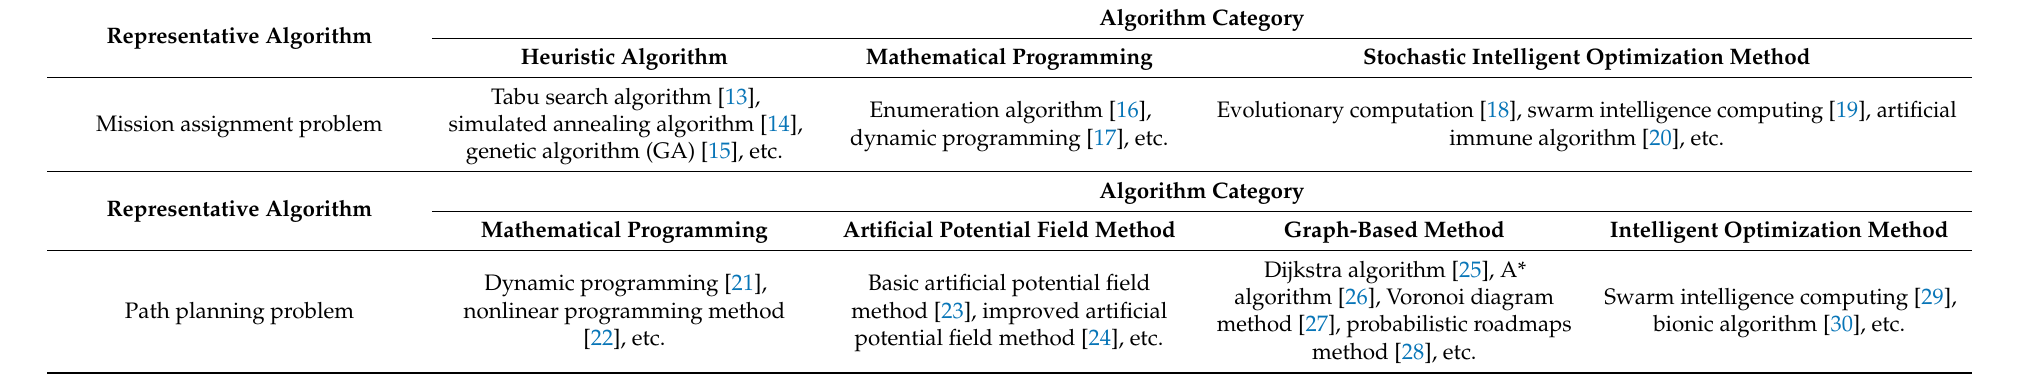
Table 1. Review of mission assignment and path planning